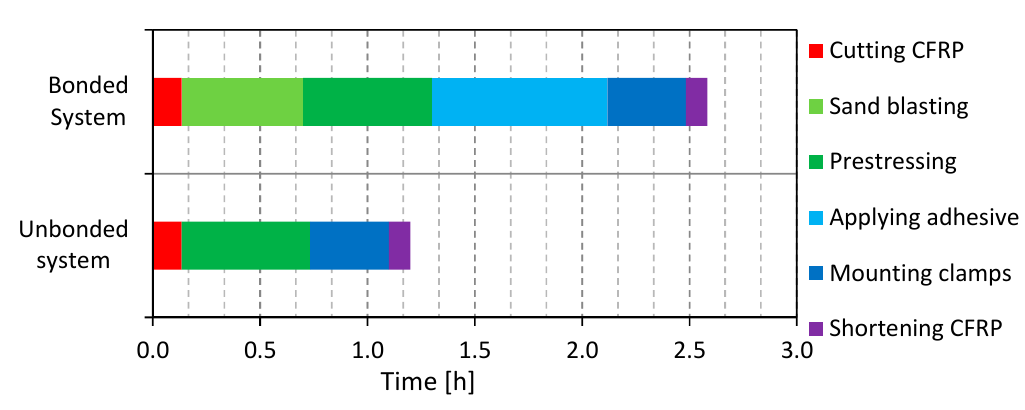
Figure 7. Comparison between the times needed for strengthening steel beams using the bonded retrofit (BR) and un-bonded retrofit (UR) systems.